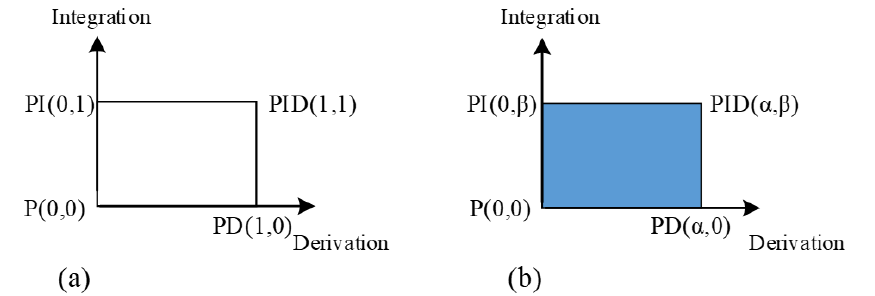
Figure 8. Integer and fractional order controllers: ( a ) without changing λ and μ variables and ( b ) with changing λ and μ variables.